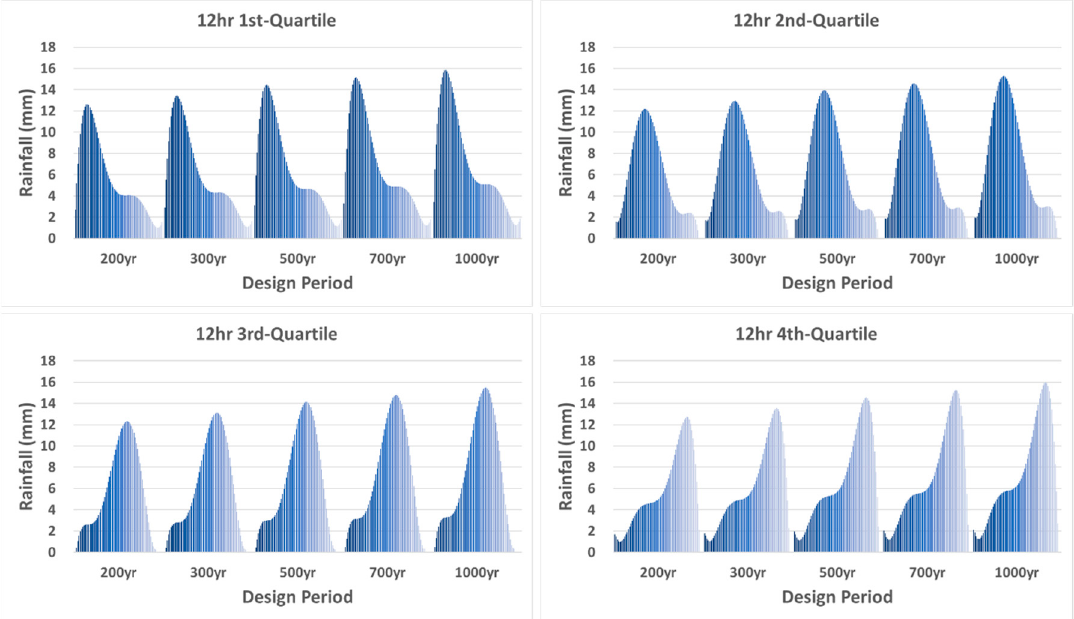
Figure 4. Twelve-hour scenario rainfall per each design period.